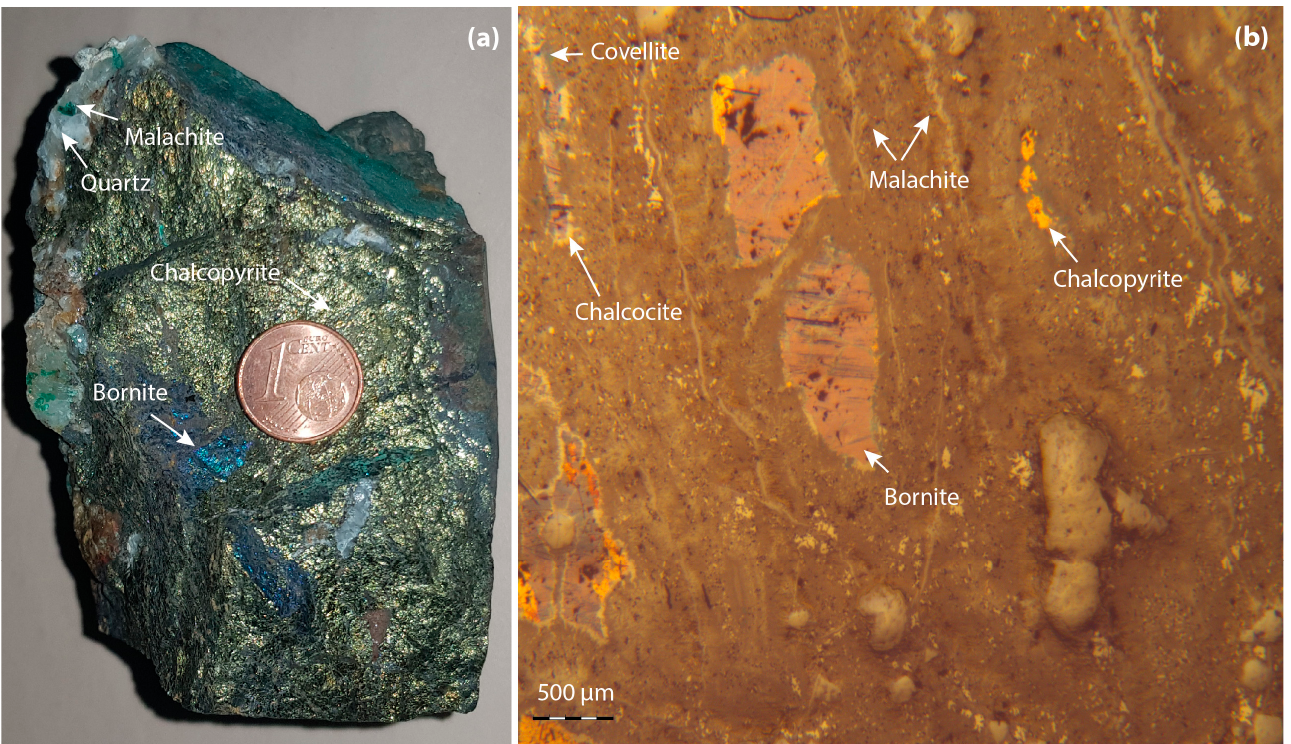
Figure 12. ( a ) Main mineral phases of the ore. ( b ) Microscopic appearance in the reflected light of the polished section of the primary paragenesis with chalcopyrite (yellow) and bornite (brown-purple) in the process of being transformed into chalcocite (grey-white), covellite (blue), and malachite (light grey), all bathed in a range of iron oxides and hydroxides.